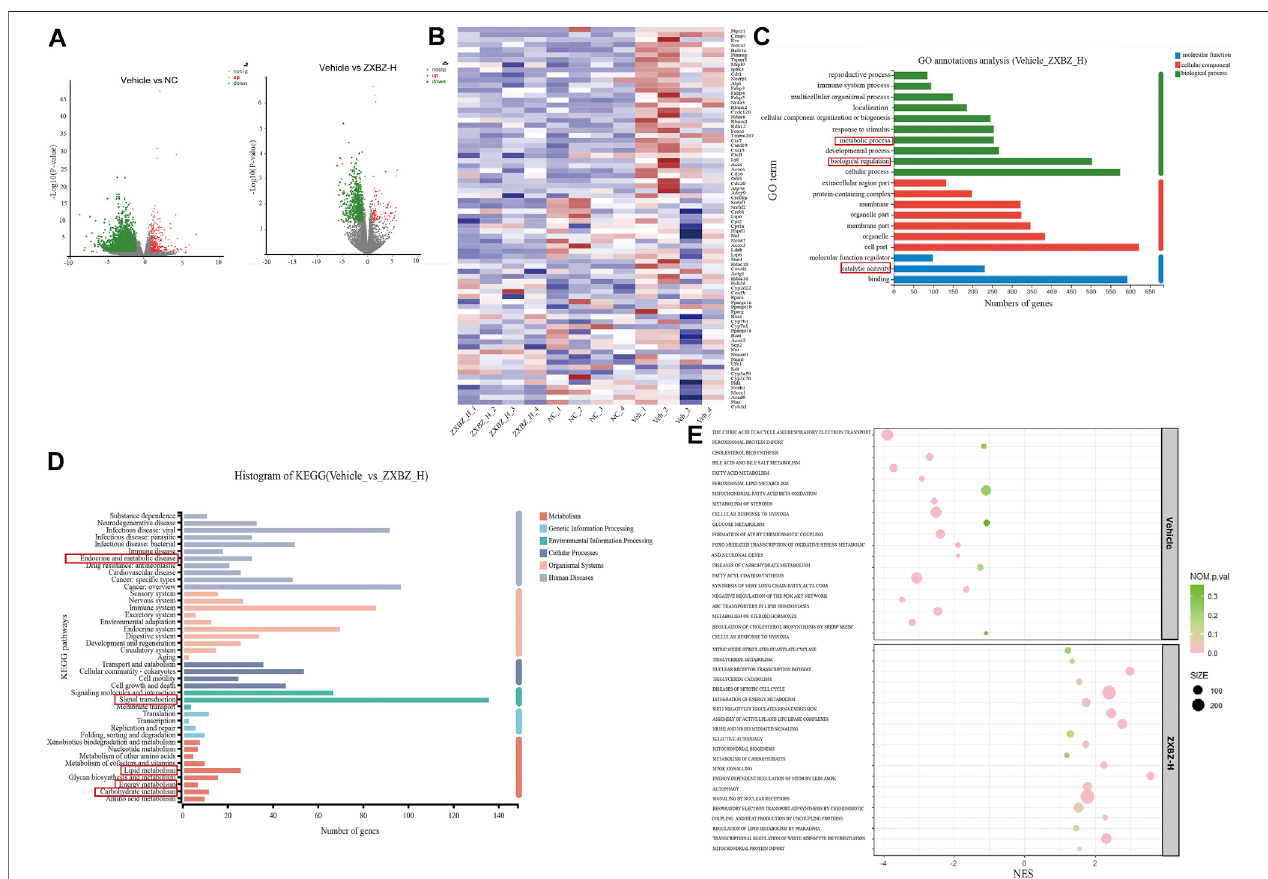
FIGURE4| RNAsequencingoflivertissueindicatedZXBZdecoctionpreventedliverinjuryviaimprovingenergymetabolism. (A) VolcanoplotsofNCorZXBZ-Hvs. vehicle. (B) Heatmap ofdifferentexpressiongenes. (C) GOannotationsofsigni fi cantlydifferentiallyexpressed genes(SDEGs) fromZXBZ-Hgroupvs.vehicle. (D) KEGG annotations of SDEGs from ZXBZ-H group vs. vehicle. (E) GSEA by the Reactome pathway database.